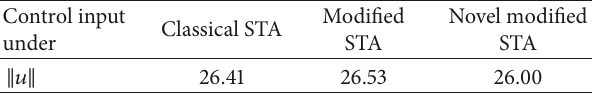
Table 4: Control effort measures for different structures of